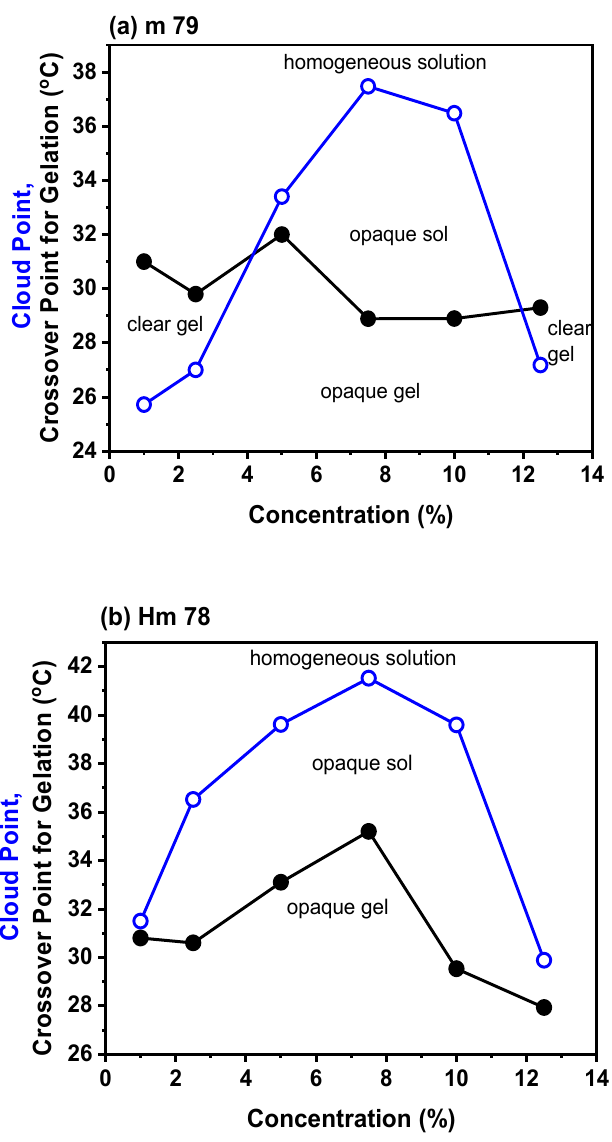
Figure 10. The comparison of the crossover point for gelation ( ● ) and cloud point ( ○ , Reference [24]) for ( a ) m79 and ( b ) Hm78 solutions.